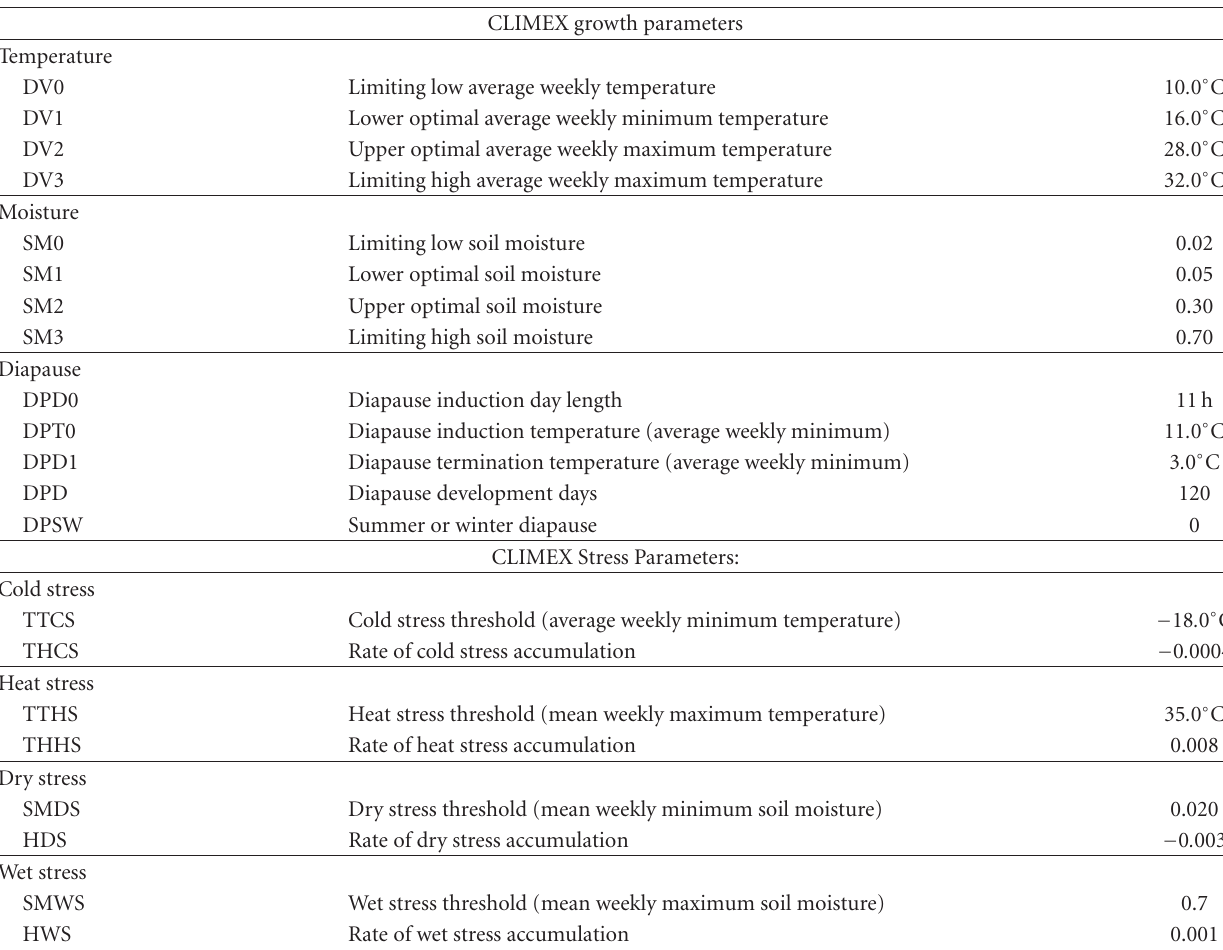
Table 1: CLIMEX parameter values used to predict potential distribution and relative abundance of Melanoplus sanguinipes in North America